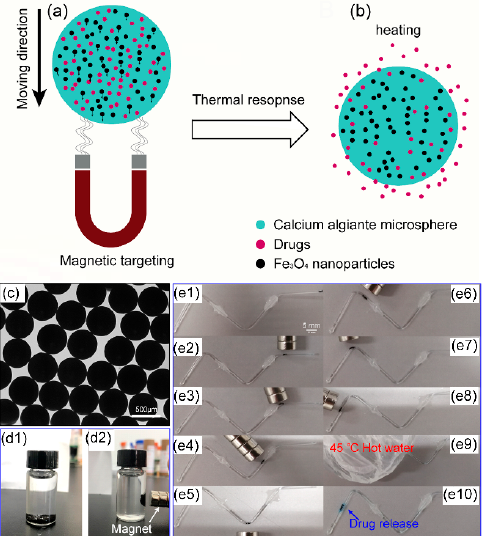
Figure 5. Application of magnet controlled calcium alginate microspheres in drug release experiment in a model vessel. ( a ) Moving mechanism of the magnetic calcium alginate microsphere; ( b )The increasing drug release rate promoted by the thermal response of calcium alginate microsphere; ( c ) Monodispersed microspheres with Fe 3 O 4 nanoparticles; ( d1 ) Microspheres with Fe 3 O 4 nanoparticles sink in water; ( d2 ) Microspheres with Fe 3 O 4 nanoparticles could be attracted by a magnet; ( e1 – e8 ) Microspheres with Fe 3 O 4 nanoparticles can be guided to move by the magnet in a capillary tube; ( e9 ) The microspheres were treated by a hot water bag to promote drug release; ( e10 ) Blue-O in the microspheres were released after hot compress